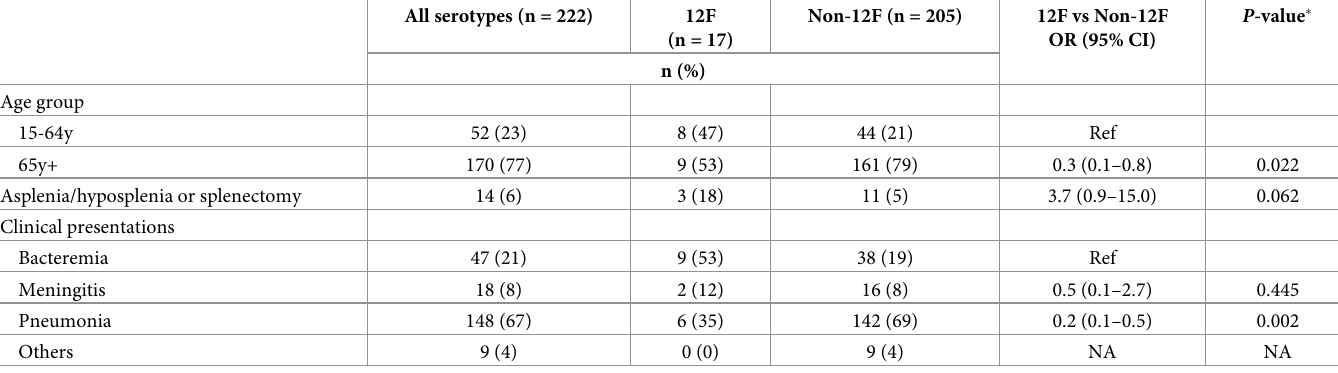
Table 2. Comparison of clinical parameters in adult patients with fatal IPD caused by 12F serotype and non-12F serotypes. All serotypes (n =